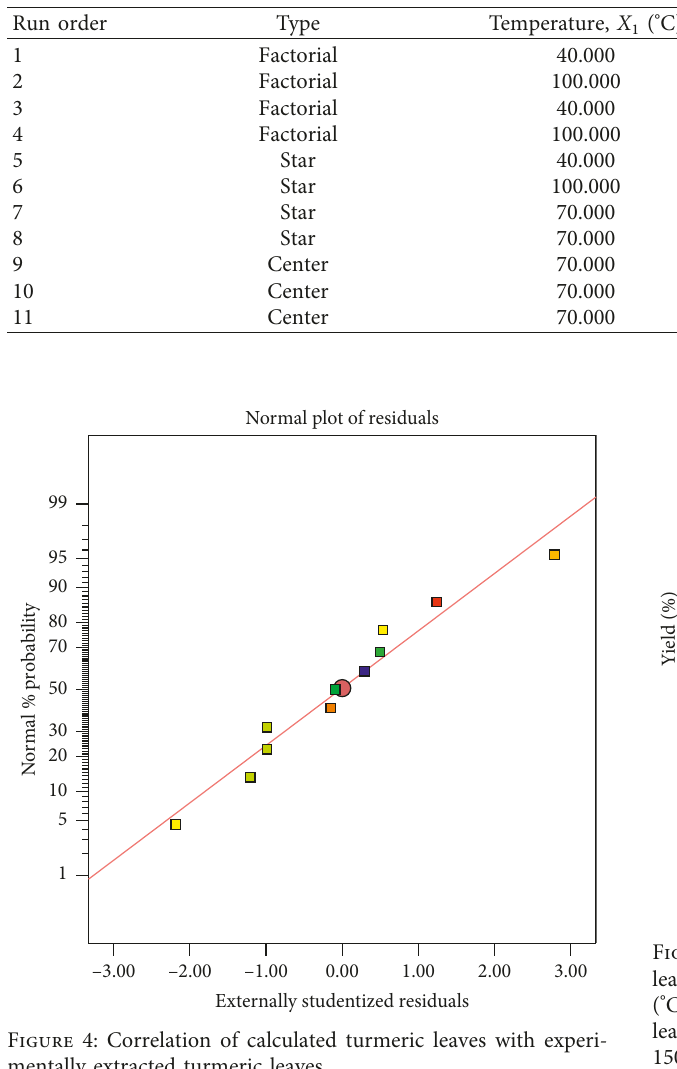
Table 1: Central composite design matrix of two test variables in coded values and observed responses from 11 extraction conditions for the extraction of turmeric leaves.